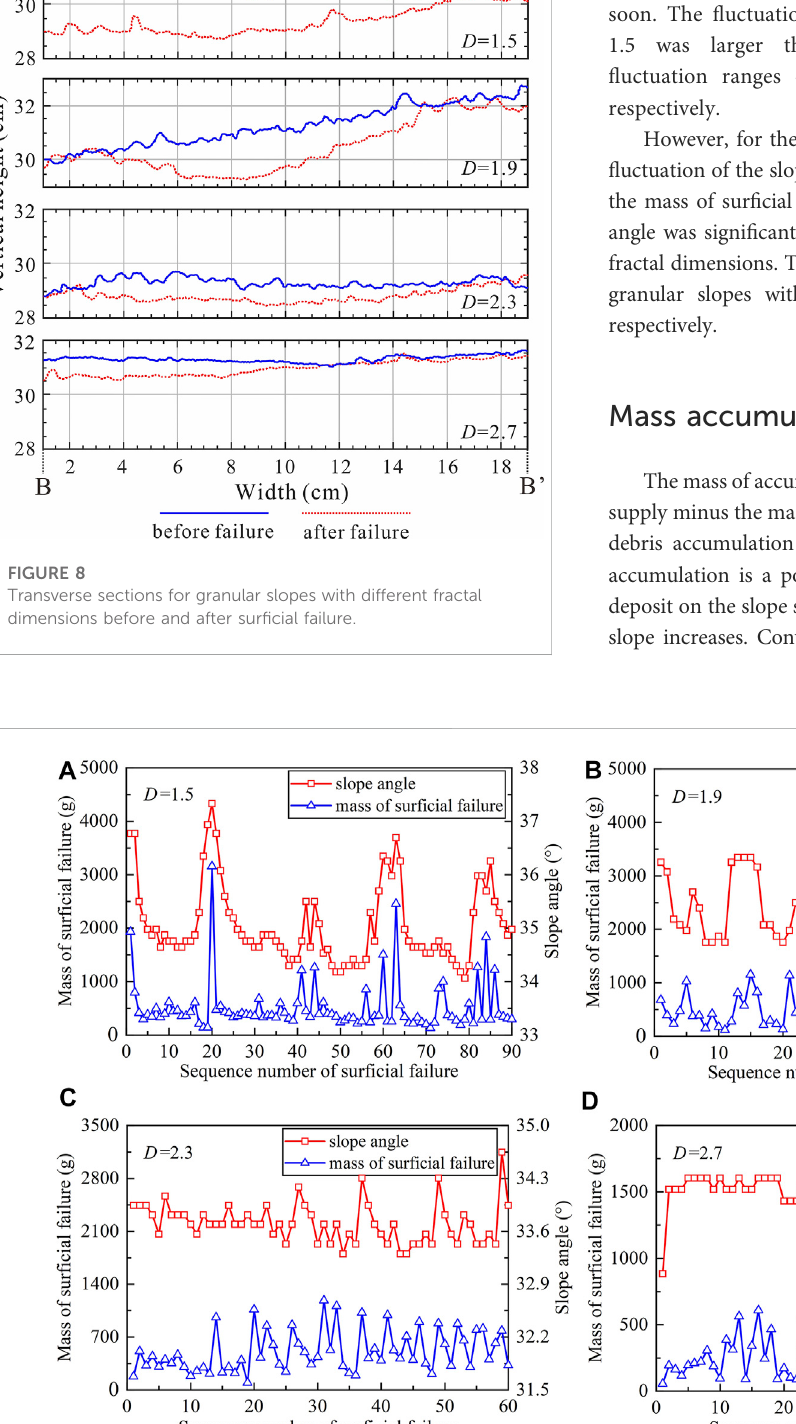
Frontiers in Earth